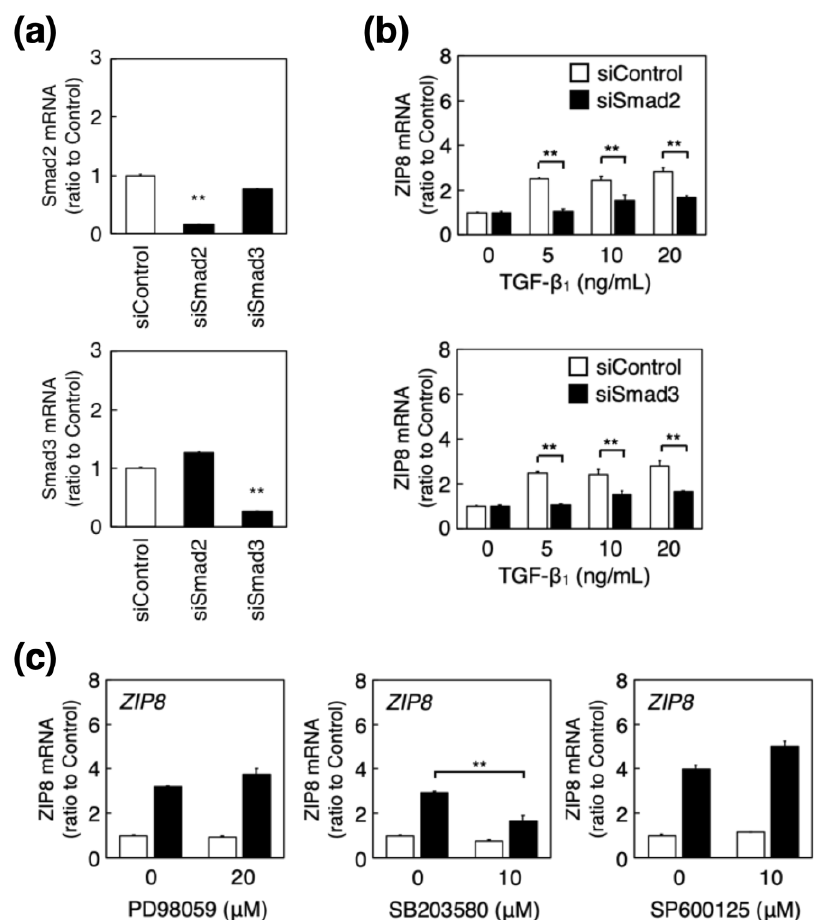
Figure 4. Involvement of Smad2/3 and MAPK signaling in the induction of ZIP8 by TGF- β 1 in vascular endothelial cells. ( a ) Bovine aortic endothelial cells were transfected with control, Smad2, or Smad3 siRNAs for 24 h, and Smad2 and Smad3 mRNA expression levels were determined using real-time reverse transcription polymerase chain reaction (RT-PCR). Each value represents the mean ± S.E. of three technical replicates; ** p < 0.01 represents statistical significance compared with the siControl. ( b ) Bovine aortic endothelial cells transfected with control, Smad2, or Smad3 siRNAs for 24 h were treated with or without TGF- β 1 (5, 10, or 20 ng/mL) for 6 h, and ZIP8 mRNA expression was determined using real-time RT-PCR. Each value represents the mean ± S.E. of three technical replicates; ** p < 0.01 compared with the corresponding siControl. ( c ) Bovine aortic endothelial cells treated with or without PD98059 (20 μM) , SB203580, or SP600125 (1 0 μM each) for 3 h were treated with (black bars) or without (white bars) TGF- β 1 at 5 ng/mL for 6 h, and ZIP8 mRNA expression levels were determined using real-time RT-PCR. Each value represents the mean ± S.E. of three tech- nical replicates; ** p < 0.01 compared with the TGF- β 1 -treated cells without each inhibitor.